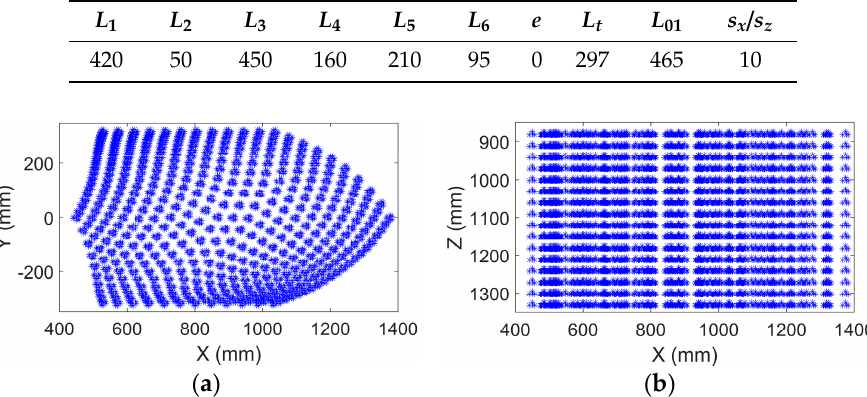
Figure 5. Reachable workspace of robot manipulator: ( a ) top view; ( b ) front view.